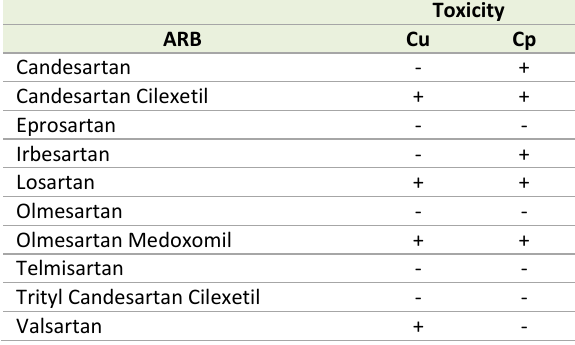
TABLE 1. Effect of the selected ARBs on Cu and Cp-induced toxicity in yeast. ‘+’ and ‘-‘ denotes effective and ineffective,